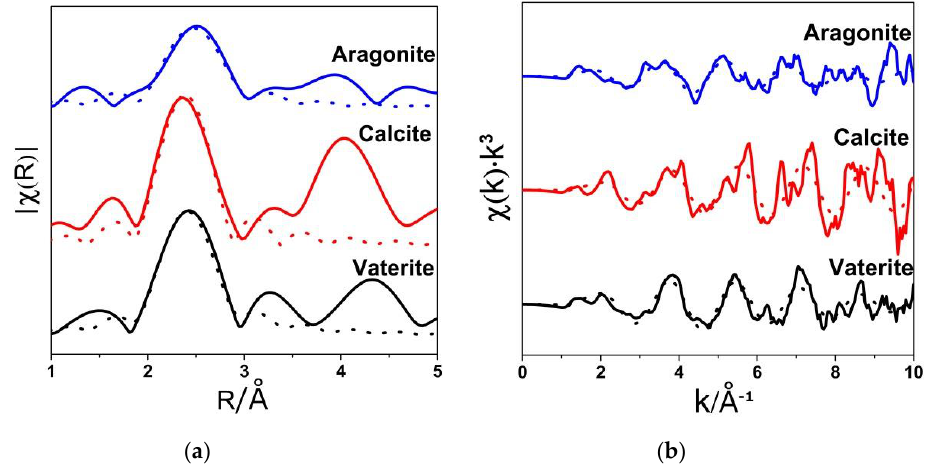
Figure A3. Ca K-edge extended X-ray absorption fine structure (EXAFS) spectra for the first coordination shell of three references, vaterite, calcite, aragonite plotted in R space (Fourier transform magnitude) ( a ) and k space ( b ). Table A1. The first coordination shell (Ca-O 1 ) fitting results of three references, vaterite, calcite, aragonite.